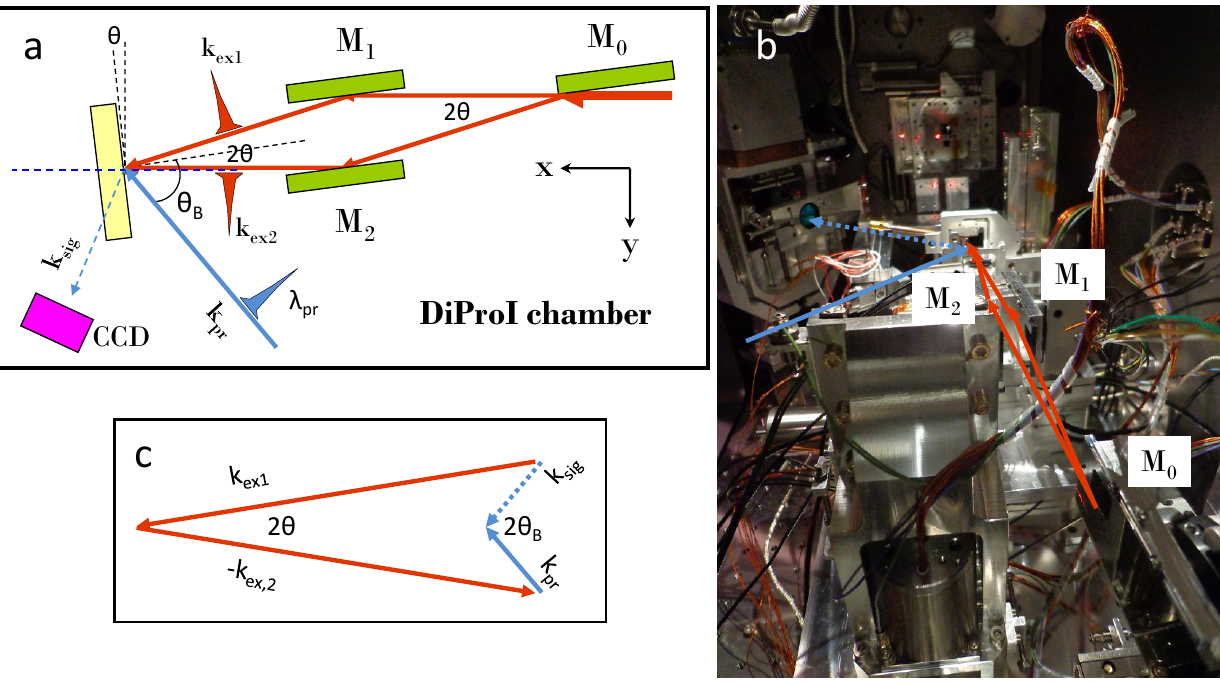
Figure 3. Optical setup for homodyne detection with extreme EUV pump/UV probe. Panel ( a ) M , beam splitter mirror; M , rotating and translating direction mirrors; red line, EUV 0 1 , 2 radiation; blue line, UV radiation. Panel ( b ) picture of the setup installed inside DiProI chamber. Panel ( c ) schematic sketch of the Bragg condition between pump, probe and signal pulses